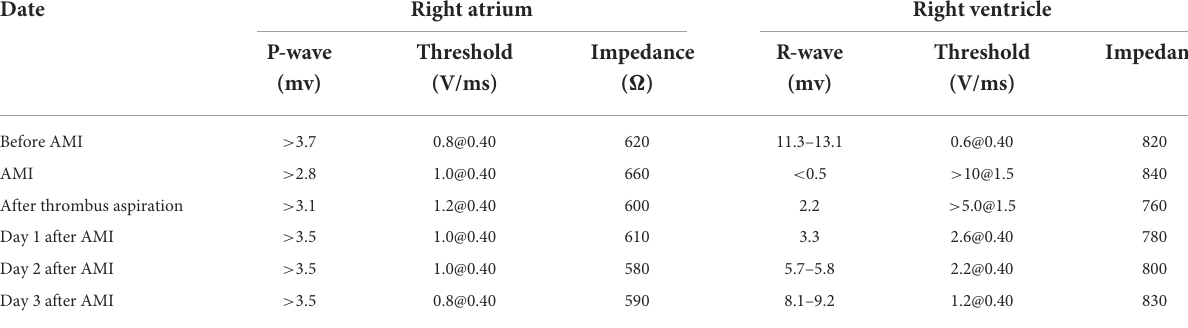
TABLE 1 Summary of right ventricular lead testing before and after the acute myocardial